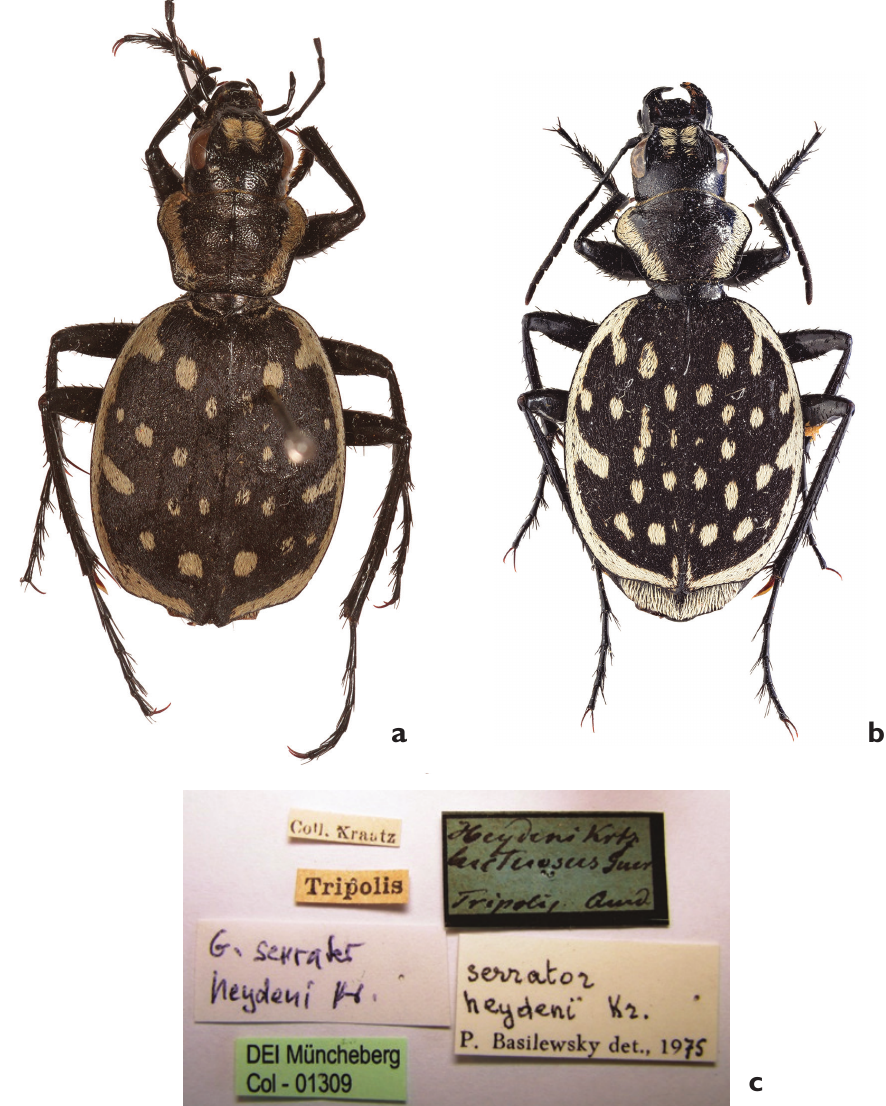
Figure 21. Dorsal habitus of Graphipterus : a G. heydeni b G. luctuosus c G. heydeni lectotypes' lables